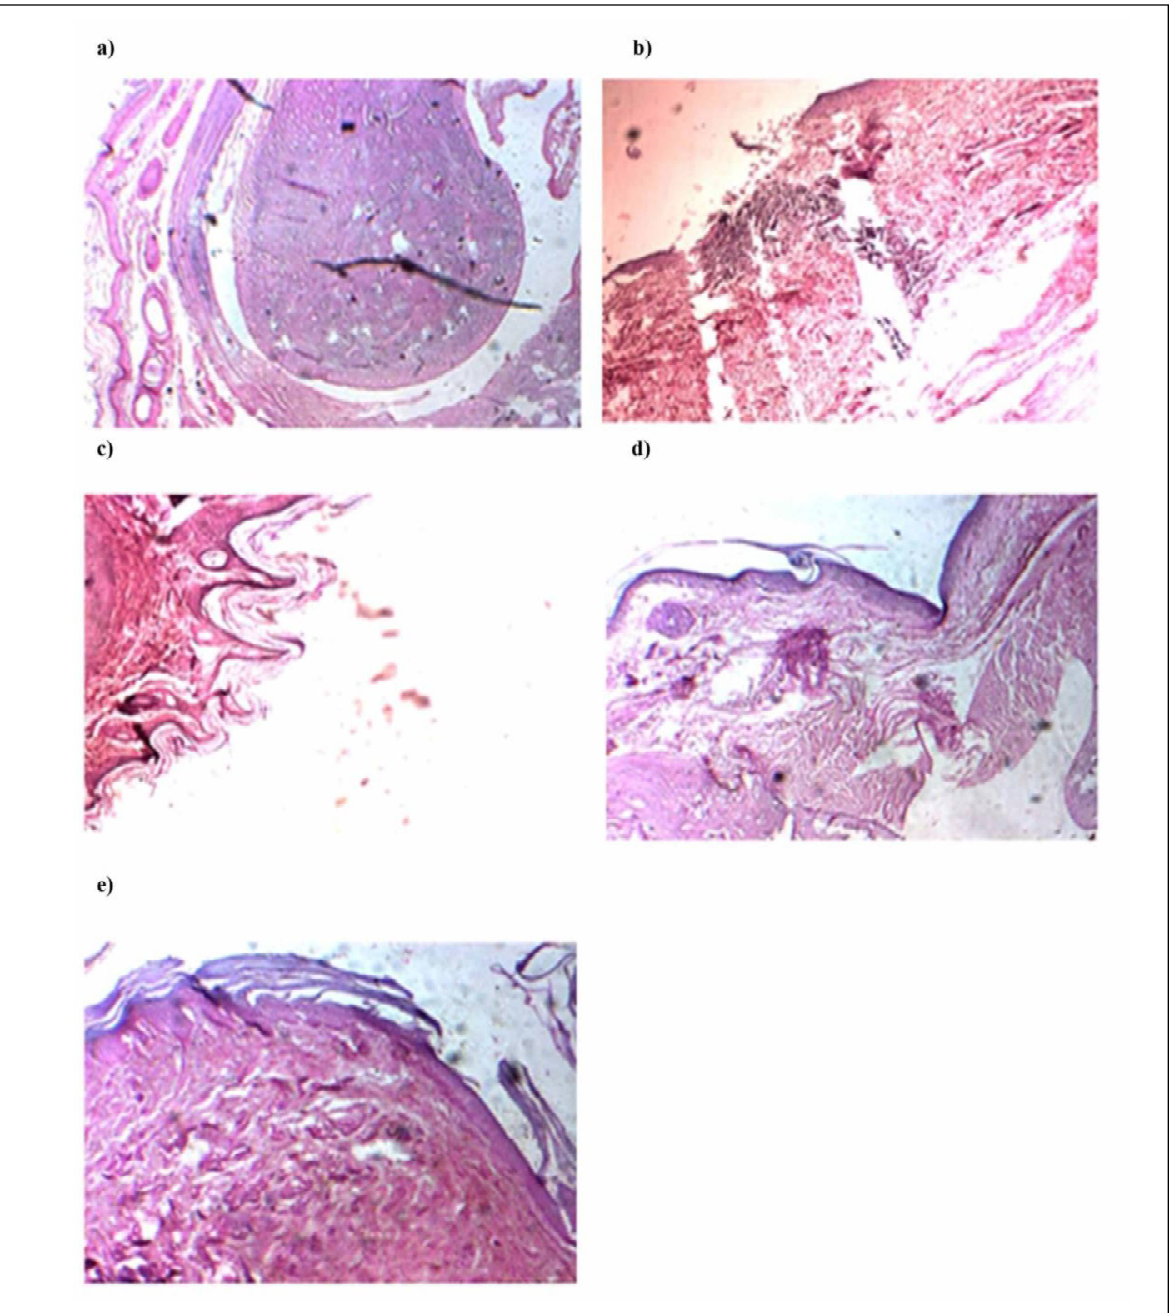
Figure 3: Histopathological changes following diabetes induction using STZ and treatment with glimepiride, lipoic acid and pyridoxamine for 8 weeks using hematoxylin and eosin staining ( 